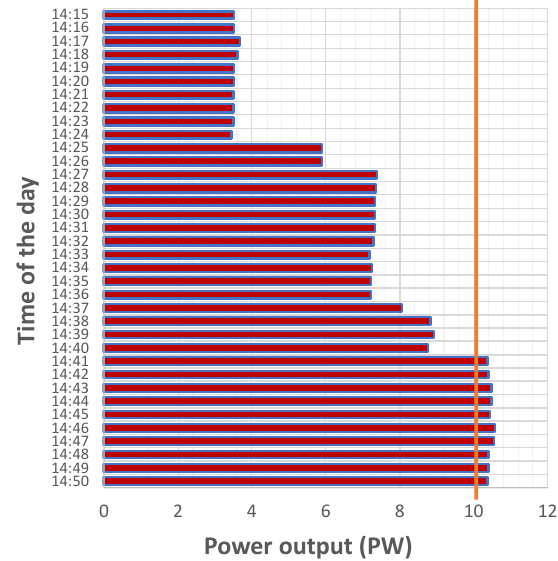
Figure 1. 10 PW shot sequence during one of the demonstrations at ELI-NP, showing the 1 shot per minute repetition rate. The full aperture pulses are demagnified on this diagnostic bench, and the near field and wavefront